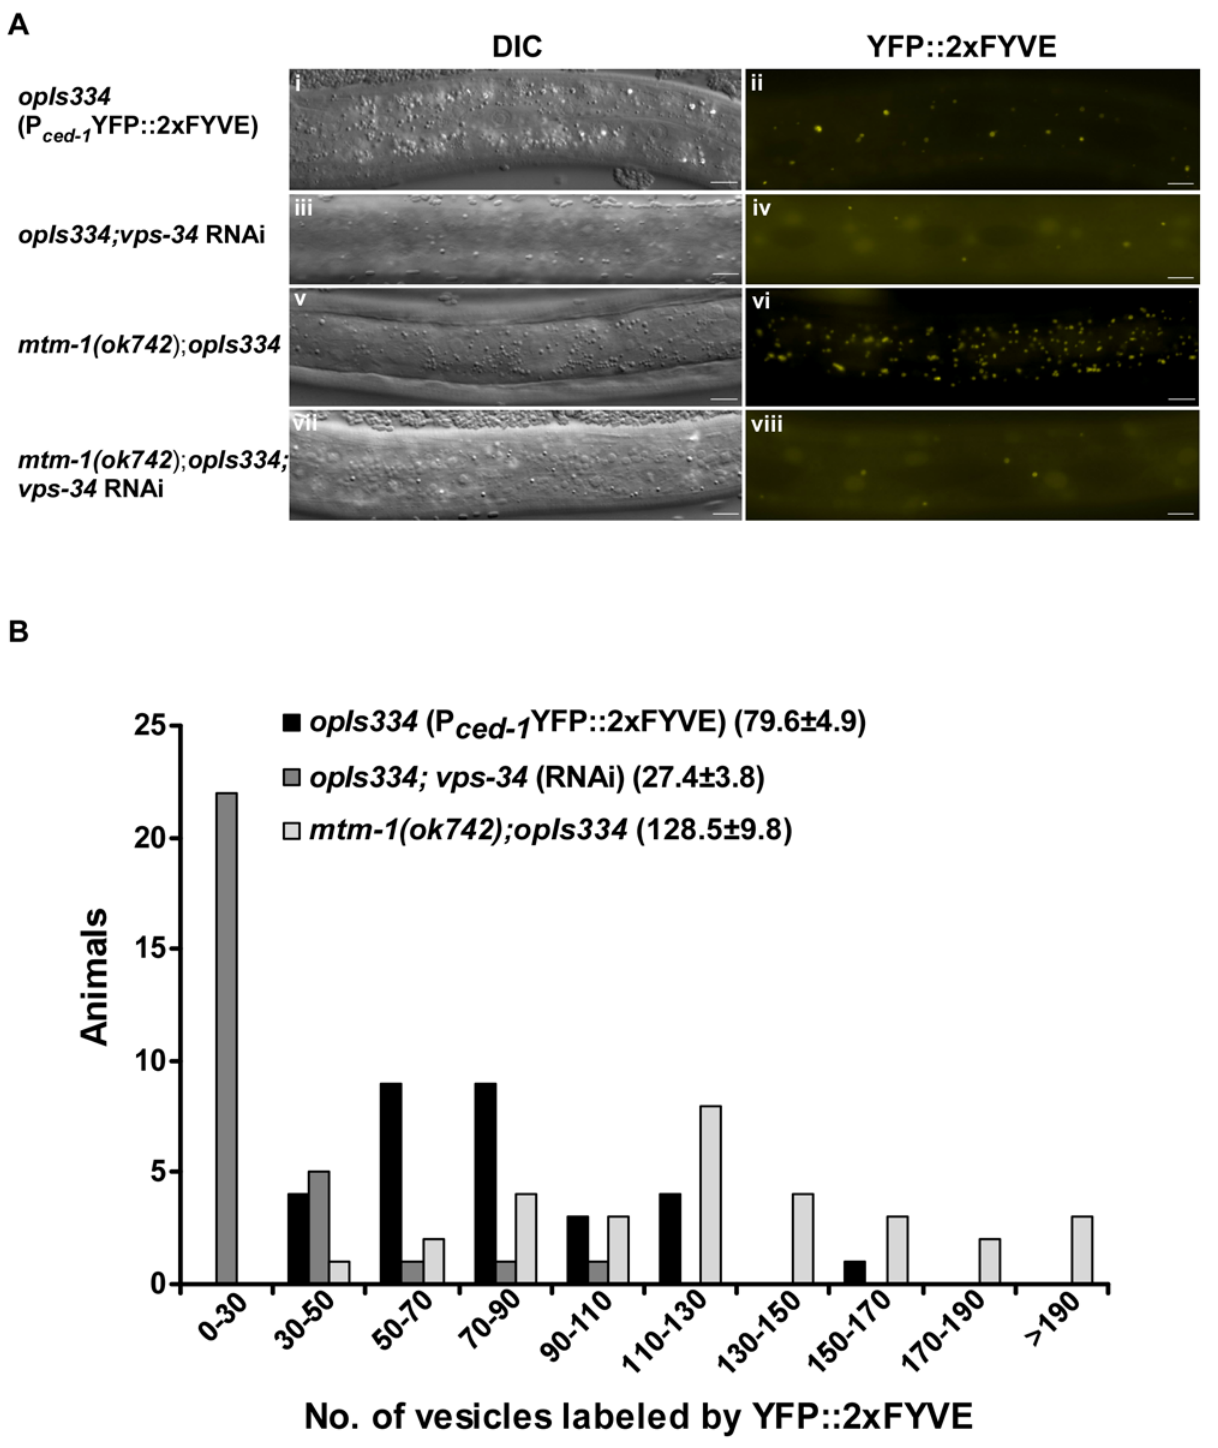
Figure 8. MTM-1 negatively regulates the level of PtdIns(3)P on intracellular vesicles. (A) The localization and accumulation of PtdIns(3)P were examined in hypodermal cells using a YFP::2xFYVE probe. mtm-1(ok742) larvae (v, vi) contained significantly higher numbers of YFP-positive vesicles than wild type (i, ii), whereas inactivation of PI3K VPS-34 by RNAi greatly reduced the PtdIns(3)P level in both wild type (iii, iv) and mtm- 1(ok742) mutants (vii, viii). Images were captured using a fixed exposure time of 550 ms for wild type and mtm-1(ok742) mutants and 1500 ms for animals treated with vps-34 RNAi. Bars: 5 m m (B) Quantification of data shown in (A). 30 L2 larvae from each strain were quantified as described in Materials and Methods. The y -axis shows the number of animals that contain YFP::2xFYVE-positive vesicles within a specific range as shown on the x - axis. The numbers in parenthesis indicate the average number of vesicles positive for YFP::2xFYVE ( 6 s.e.m).